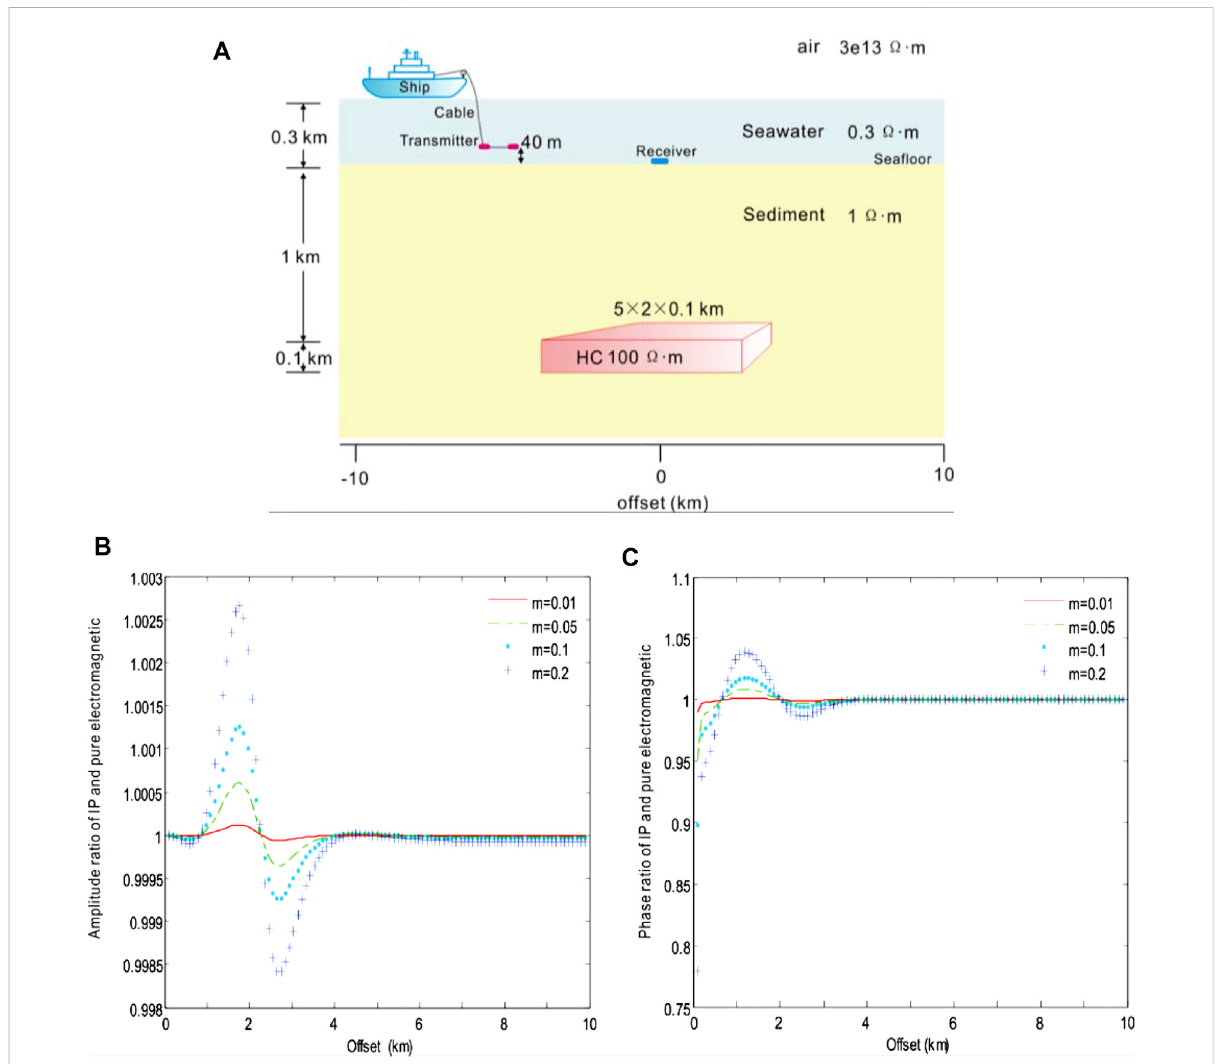
FIGURE 5 Amplitude and phase ratio of CSEM with the IP and pure electromagnetic fi eld to the Cole – Cole model of various polarizability m = 0.01 (red), 0.05 (green), 0.1 (blue), and 0.2 (light blue), respectively. (A) Geoelectric model of submarine hydrocarbons with ion-induced polarization in the 3D marine CSEM, (B) the ratio of amplitude, and (C) the ratio of